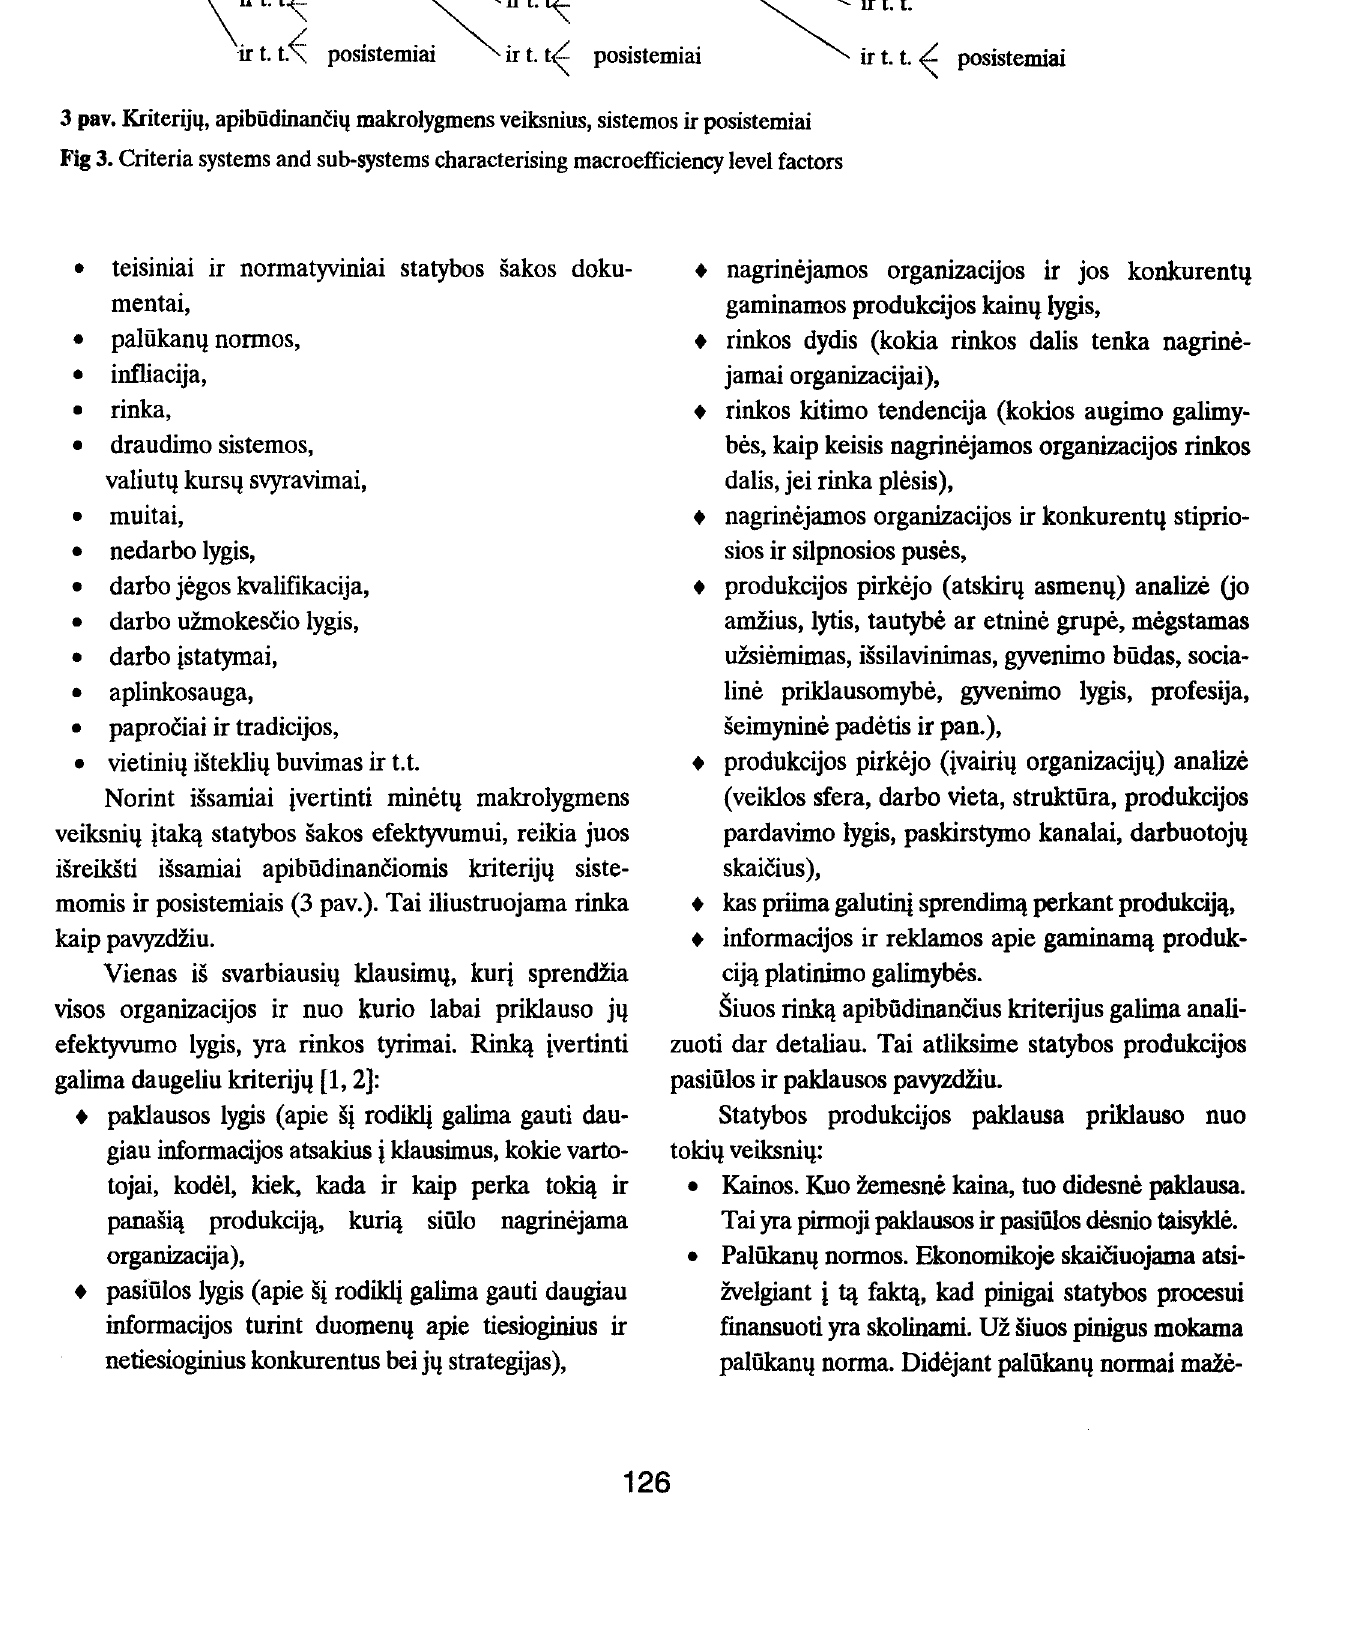
Fig 3. Criteria systems and sub-systems characterising macroefficiency level